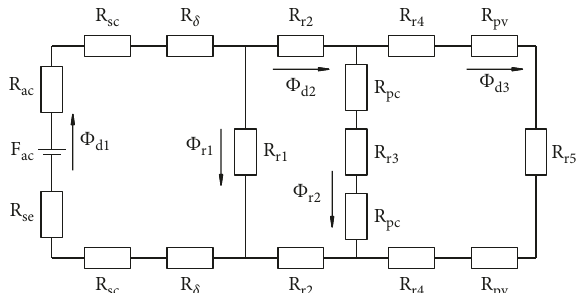
Figure 7: Equivalent magnetic circuit diagram of armature reac- tion magnetic